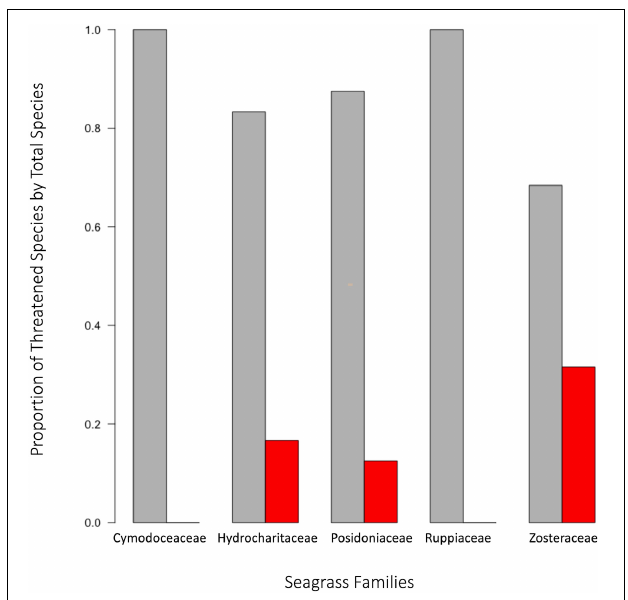
FIGURE 8 | Taxonomic distribution of extinction risk in seagrass. Population status of seagrasses were assessed using the classifications set forth by the International Union for Conservation of Nature. Proportion of threatened species was assessed as number of threatened species in a family divided by the total number of species assessed within that family. When comparing the proportions of threatened species per family to the calculated 95% confidence interval, three families were significant: Zosteraceae, Posidoniaceae, and Hydrocharitaceae. Source data are provided as a Source Data